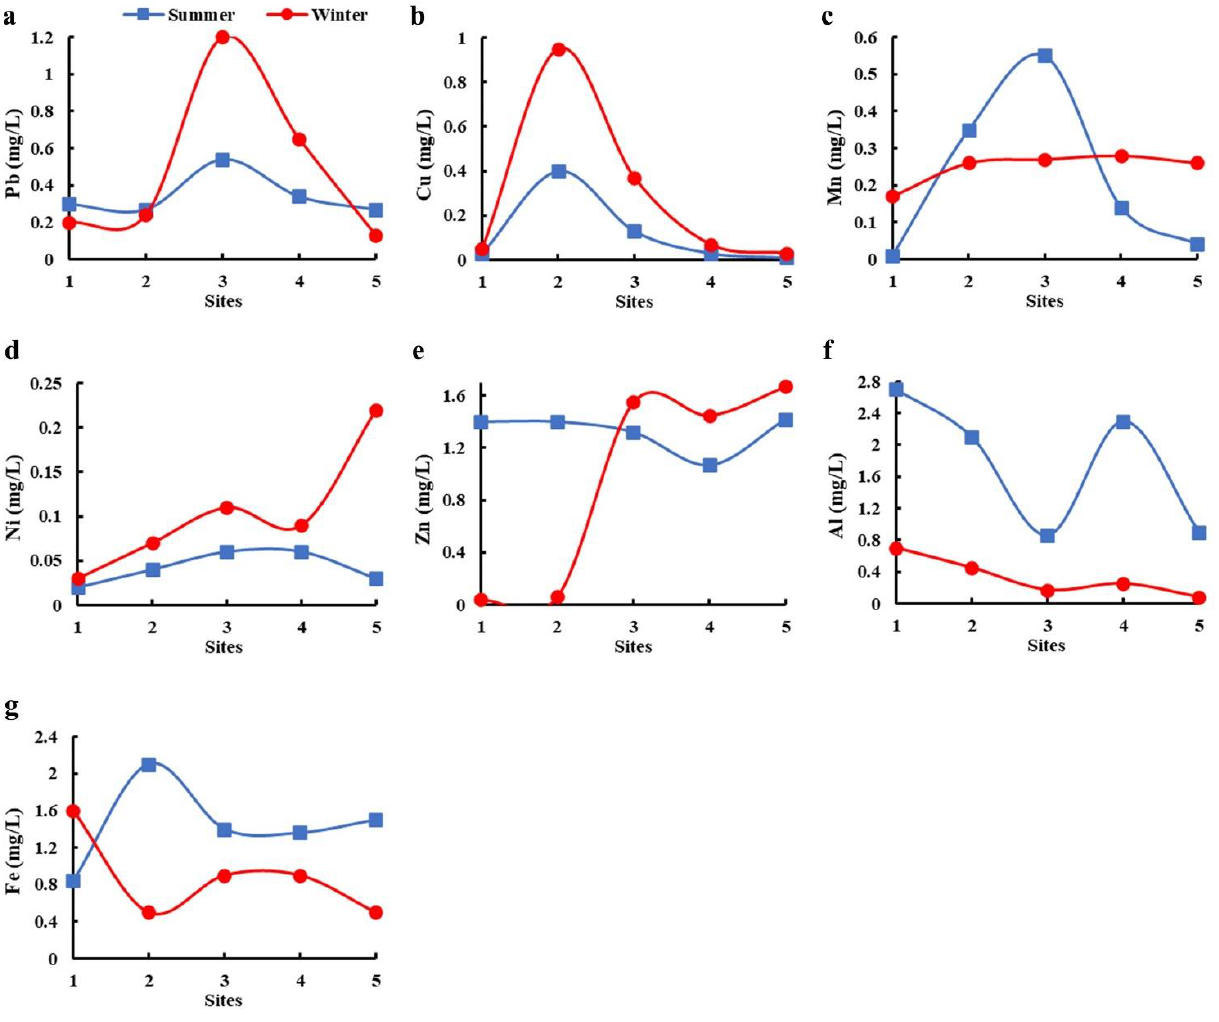
Figure 2. Spatiotemporal distribution plots of heavy metal concentrations (mg/L) in water sampling sites of Bahr El-Baqar drain during summer and winter of 2018: Pb ( a ), Cu ( b ), Mn ( c ), Ni ( d ), Zn ( e ), Al ( f ), and Fe ( g ). Table 1. Summary statistics of heavy metal concentrations (mg/L) in water of Bahr El-Baqar drain.